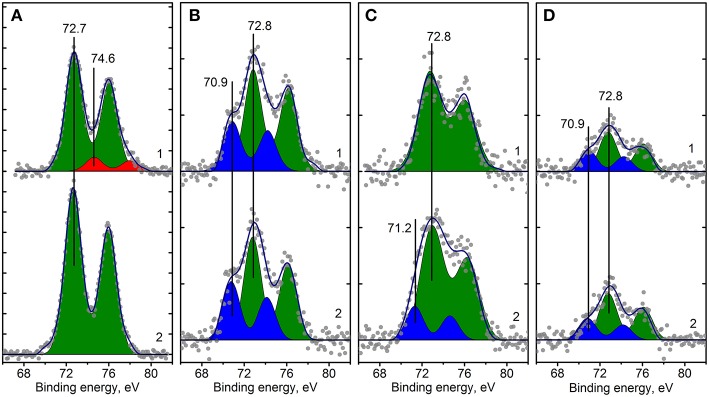
Curve fitted Pt4f XPS spectra for Pt/Ce-600 (A), Pt/Ce-900 (B), Pt/CeSn-600 (C) and Pt/CeSn-900 (D) samples, before (curves 1) and after CO+O2 reaction (curves 2). Ticks range on the Y-axis is 50 counts.